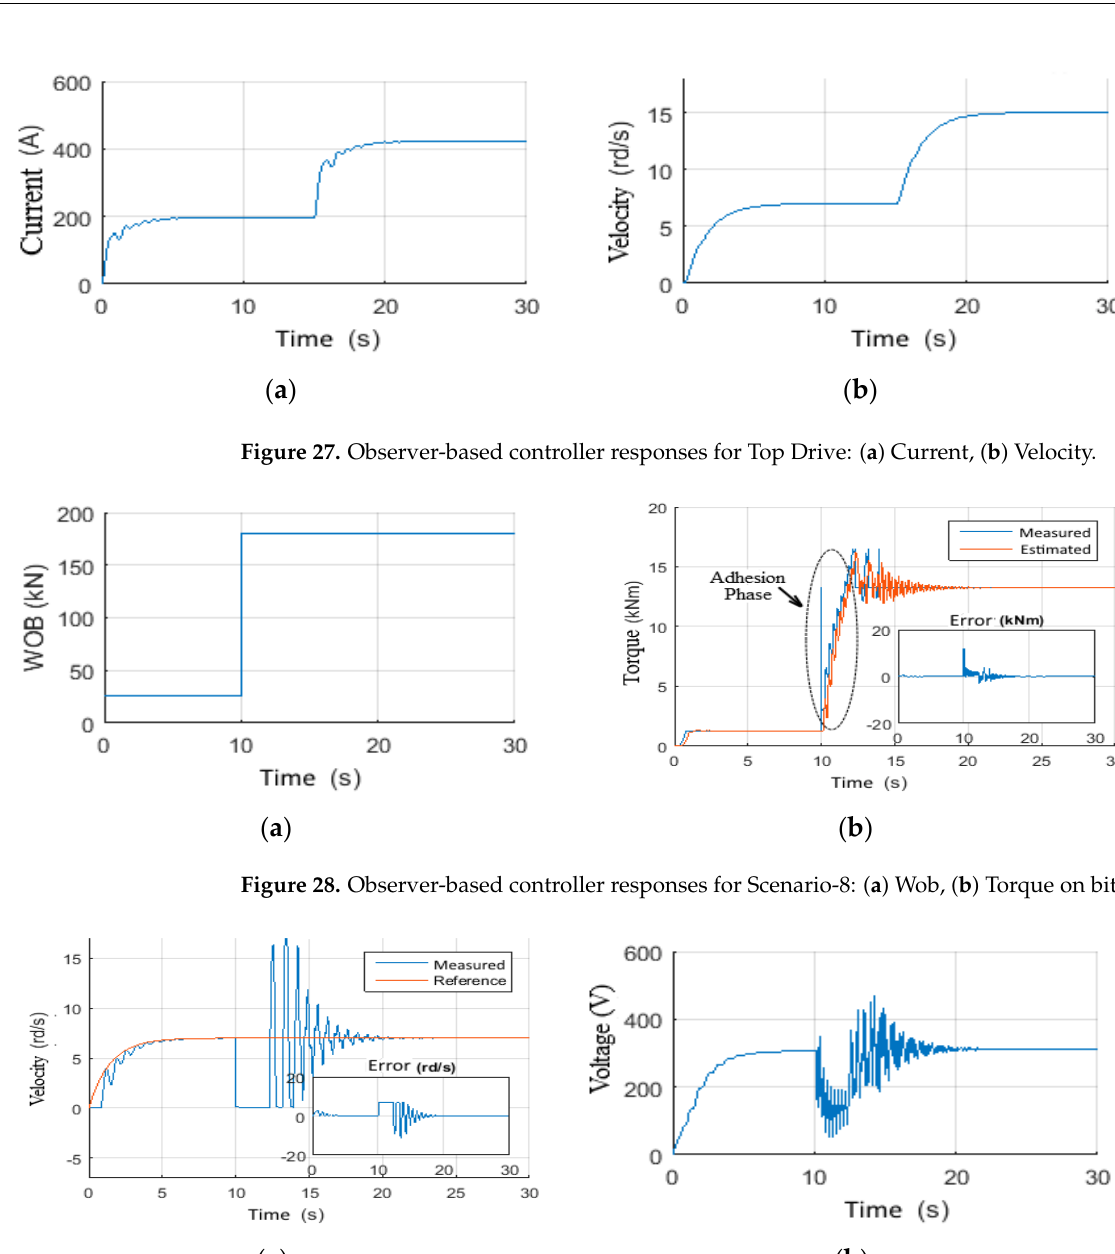
Figure 26. Observer-based controller responses: ( a ) Controlled drill bit velocity, ( b ) Control volt- age.